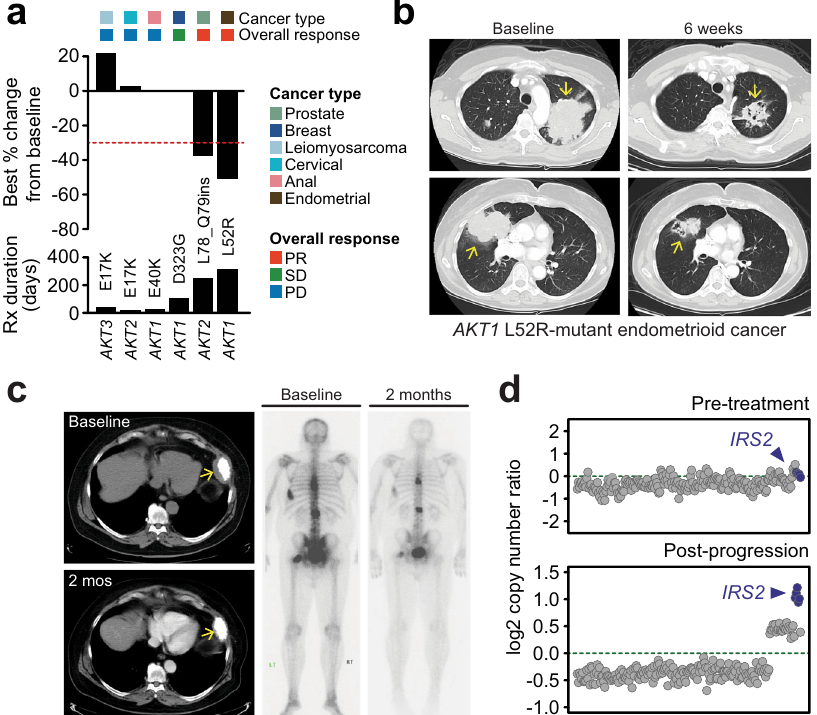
Fig. 5 Clinical sensitivity of diverse AKT mutations in a phase II basket trial of capivasertib. a The ef fi cacy of ATP-competitive AKT inhibition was explored in a phase II clinical trial of capivasertib in patients harboring AKT1-3 alterations (excluding AKT1 E17K-mutated ER + breast cancer). The clinical response of patients to capivasertib therapy with tumors harboring non-E17K AKT1-3 mutations is shown. b Computed tomography (CT) indicating a partial response (indicated by arrows) in an endometrial cancer patient with an AKT1 L52R mutation that lasted nearly a year. c Response of a castration-resistant metastatic prostate cancer patient to capivasertib treatment whose tumor harbored a novel AKT2 L78_Q79ins(HANTFVIRCL) indel mutation. Left and right are CT and bone scans at baseline and two months after treatment initiation. The left panel shows the resolution of the soft tissue metastatic compartment (yellow arrow). d Sequencing of pre-treatment and post-progression tumor tissue indicated the acquisition of a focal ampli fi cation of IRS2 (blue; x -axis is chromosome 13) present only in the tumor after AKT inhibitor